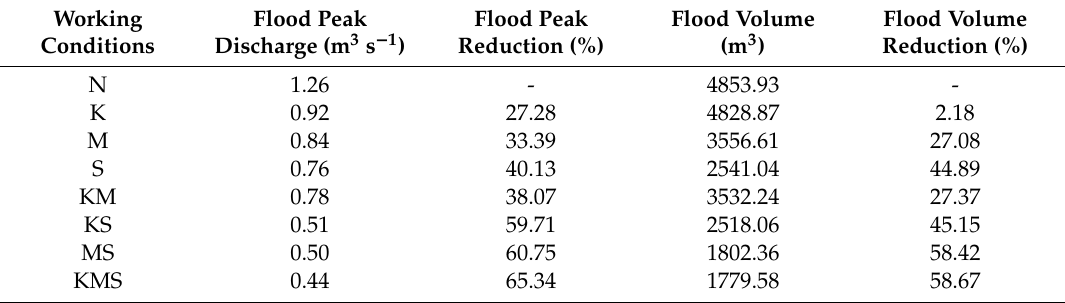
Figure 3. Simulation results under different working conditions. Table 3. Flood characteristic parameters under different working conditions.